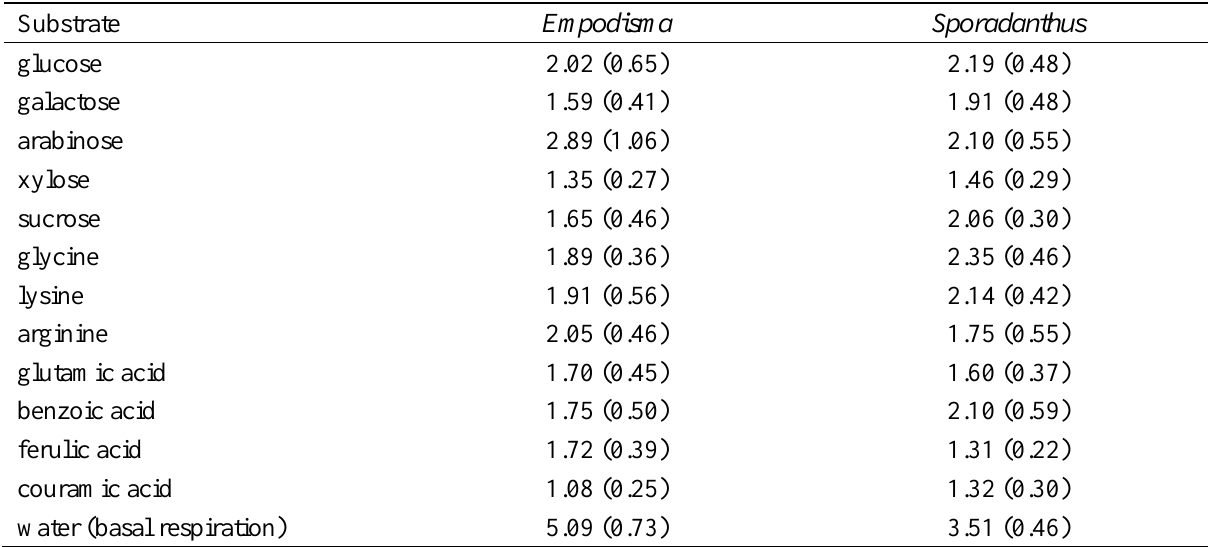
Table 4. Carbon dioxide (CO 2 -C) fluxes (mg g –1 ) after the addition of 12 carbon substrates and water, from peat under Empodisma and Sporadanthus vegetation, with no differentiation between hydrological zones or sites. Values in brackets represent the standard error of the mean ( n = 24). There were no differences between the vegetation types for any of the substrates tested ( P <